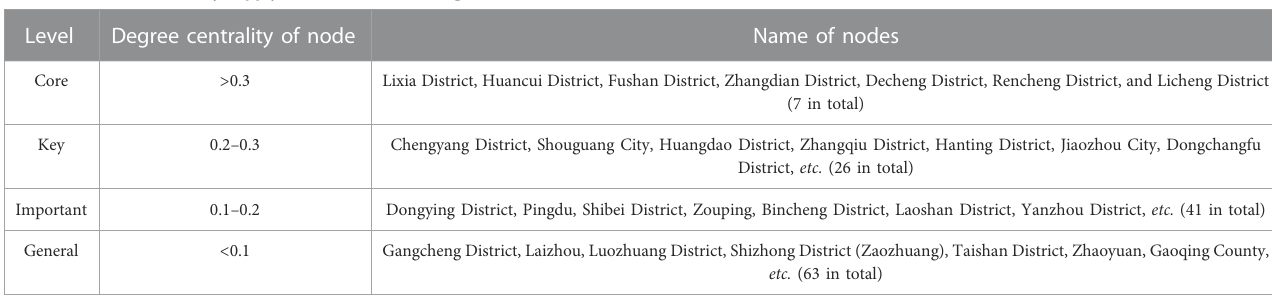
TABLE 2 Node levels of city supply networks in